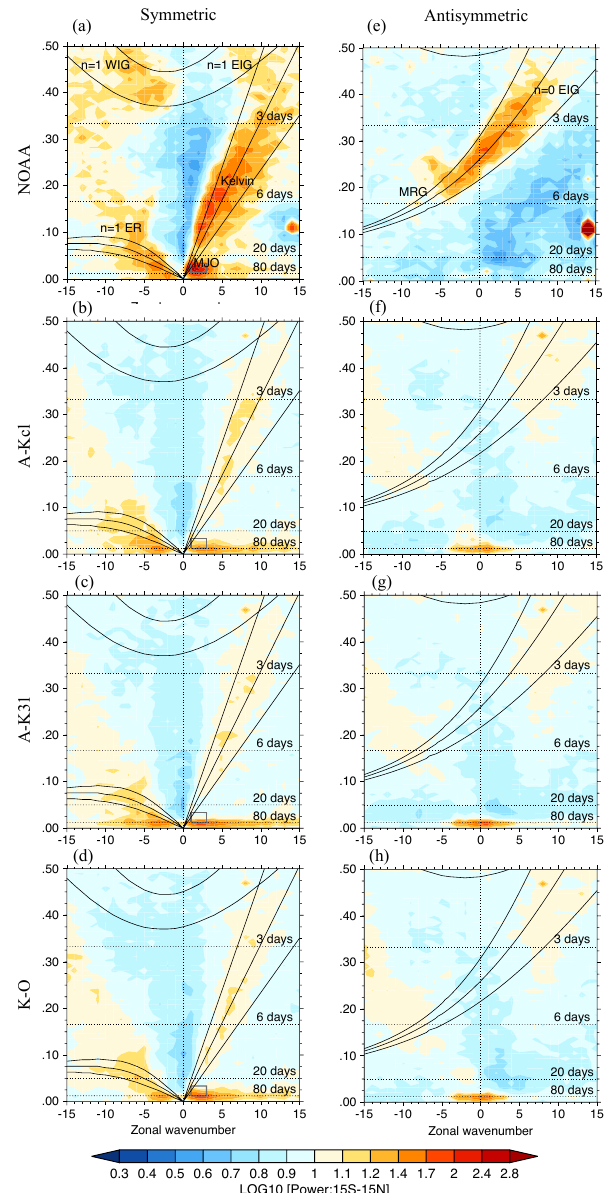
Figure 6. Zonal wave number-frequency power spectra of anoma- lous OLR for symmetric (a – d) and antisymmetric (e – h) compo- nents divided by the background power for NOAA satellite obser- vations (a, e) , A-Kcl (b, f) , A-K31 (c, g) and K-O (d, h) . Solid lines represent dispersion curves at equivalent depths of 12, 25 and 50m. Theoretical modes highlighted in observations: ER, Kelvin, MJO, MRG, and eastward and westward inertio-gravity (EIG, WIG). The grey box indicates the MJO spectral region of 30–80 days and wave numbers